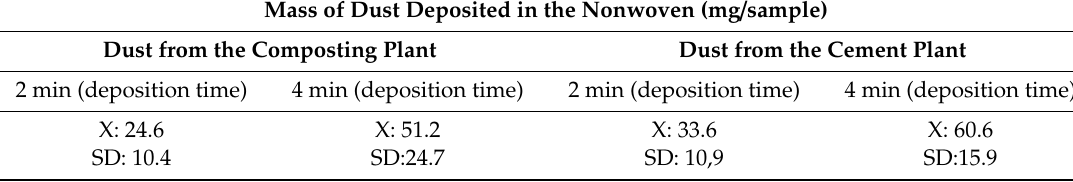
Table 2. Dust content in the nonwoven